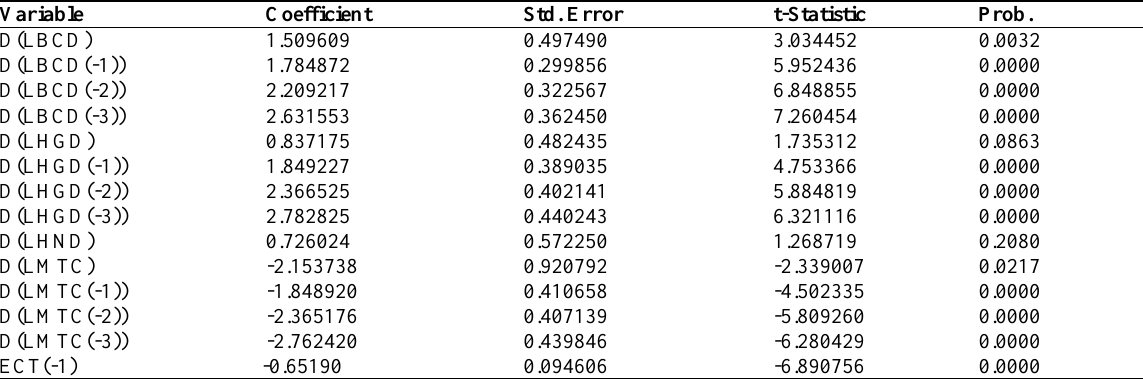
Table 7: Error correction and short-term dynamics